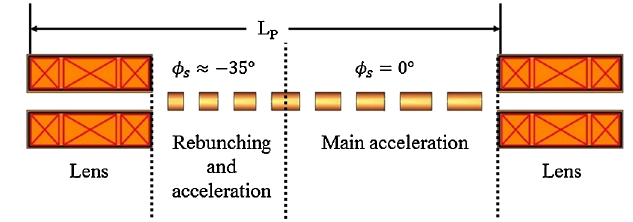
FIG. 19. A schematic view of the CH-DTL, showing the separated function concept of the KONUS-beam dynamics.